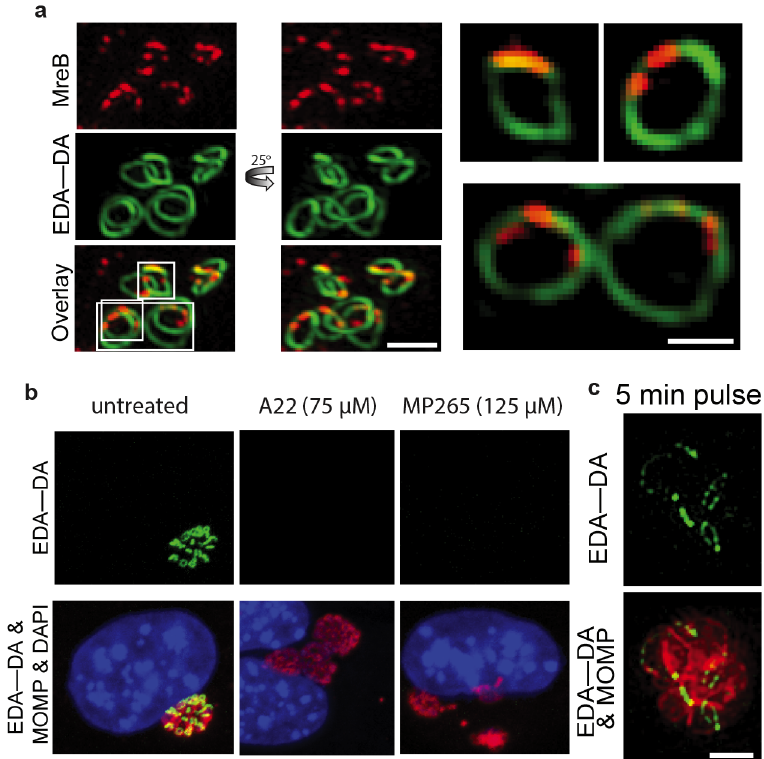
Fig 6. Chlamydial MreB is patchy, co-localizes to PG rings, and is required for chlamydial PG synthesis. (a) SIM of chlamydial PG localization in relation to polymerized MreB in inclusions 18 hpi incubated with EDA — DA for one hour. Right-most panels are magnifications of single imaging planes from a . (b) Chlamydial inclusions (18 hpi) grown in the presence of 4 mM EDA — DA and MreB inhibitors A22 or MP265 (added 12 hpi). MOMP and PG labeling is the same as in Fig 2. ( c ) SIM of EDA-DA labeled PG (green) and MOMP (red) within chlamydial inclusions (18 hpi) incubated with 4 mM EDA-DA for 5 minutes. Scale bars = 1 μ